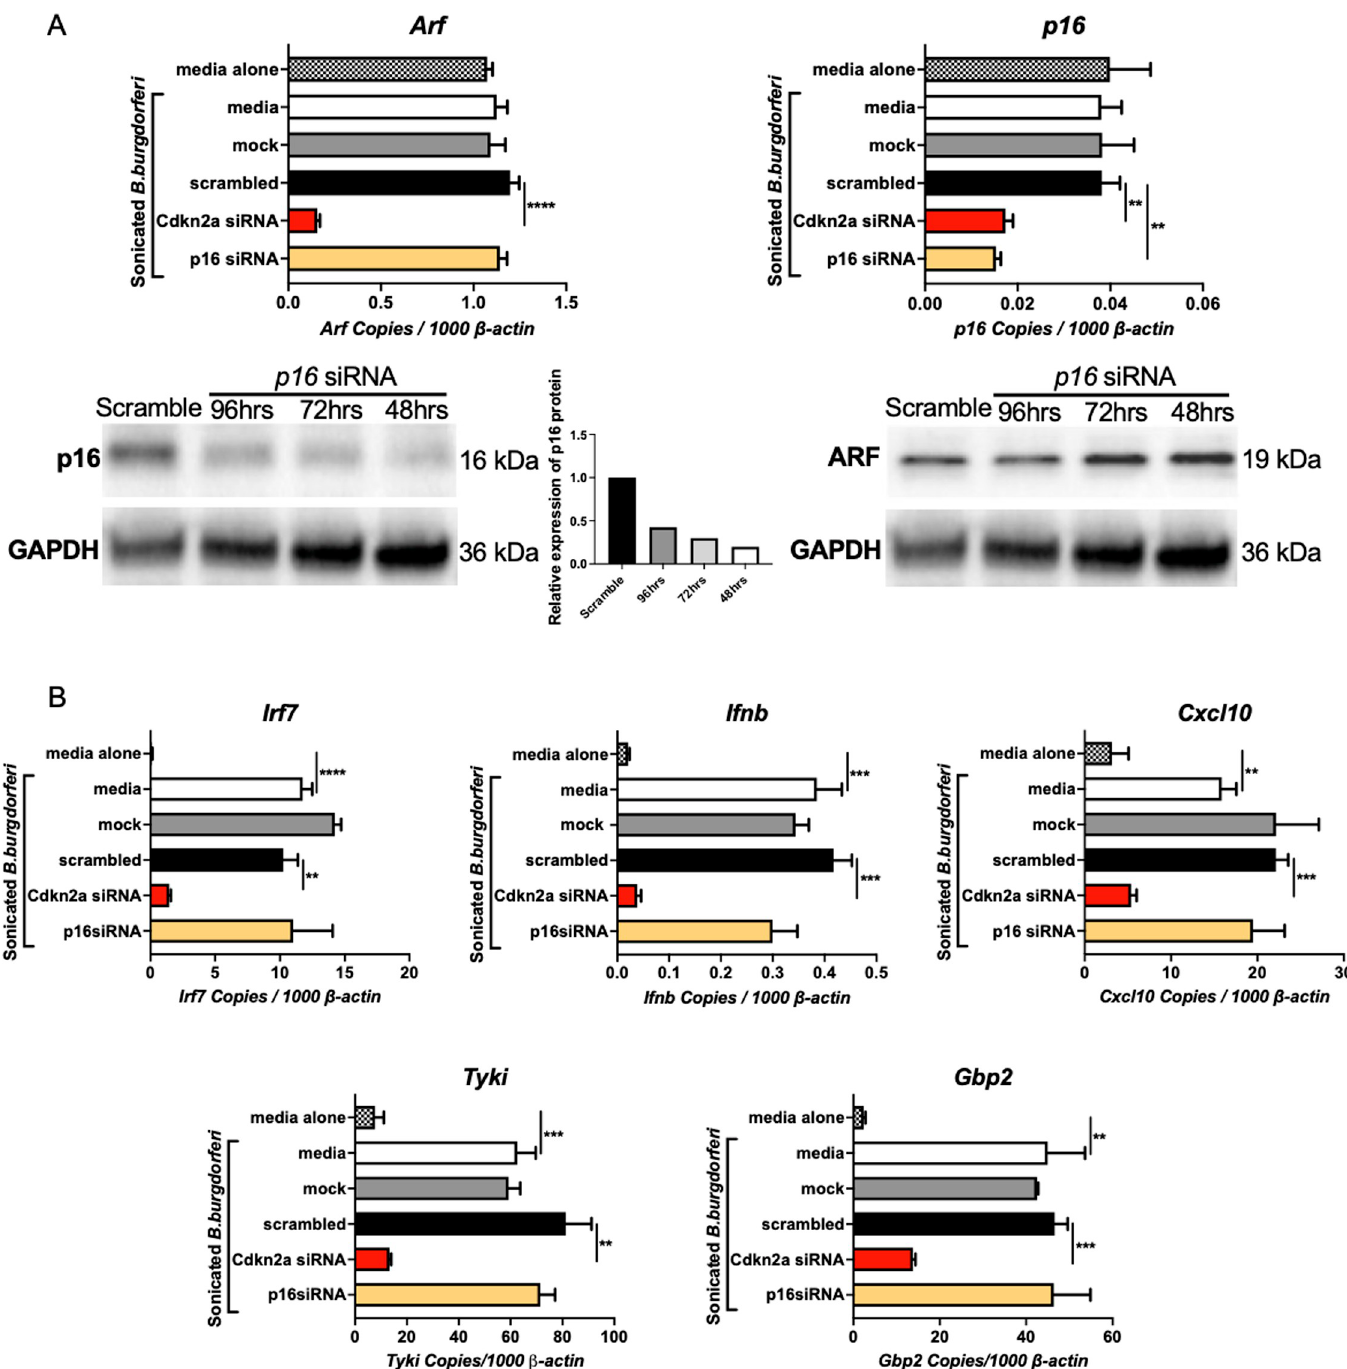
Fig 3. IFN β modulating activity of Cdkn2a is not due to p16 protein. A) Transfection of p16 siRNA (100 nM) into B6.C3- Bbaa1 BMDMs silenced p16 . ARF and p16 expression levels were evaluated by qPCR with normalization to β -actin and Western blot following treatment with 5 μ g/ml sonicated B . burgdorferi for 6 h. Significance was determined by Student t -test. Data are shown as mean ± SEM (n = 3 per group). B) The impact of selective silencing of p16 on expression of B . burgdorferi -stimulated Ifnb and the IFN downstream genes Cxcl10 , Tyki , and Gbp2 in B6.C3- Bbaa1 BMDMs was determined by qPCR normalized to β -actin . Error bars indicate SEM (n = 3 per group). �� p < 0.01, ��� p < 0.001, ���� p < 0.0001.